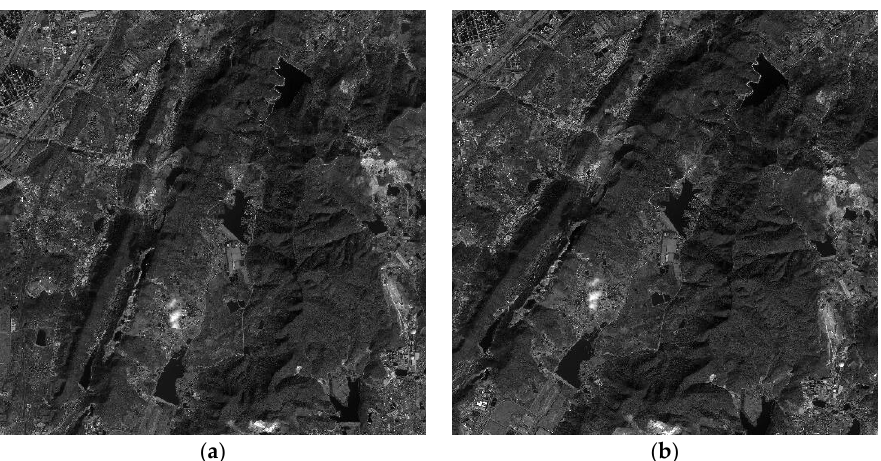
Figure 3. Comparison of panchromatic images before and after orthorectification. ( a ) Panchromatic image before orthorectification; ( b ) panchromatic image after orthorectification.